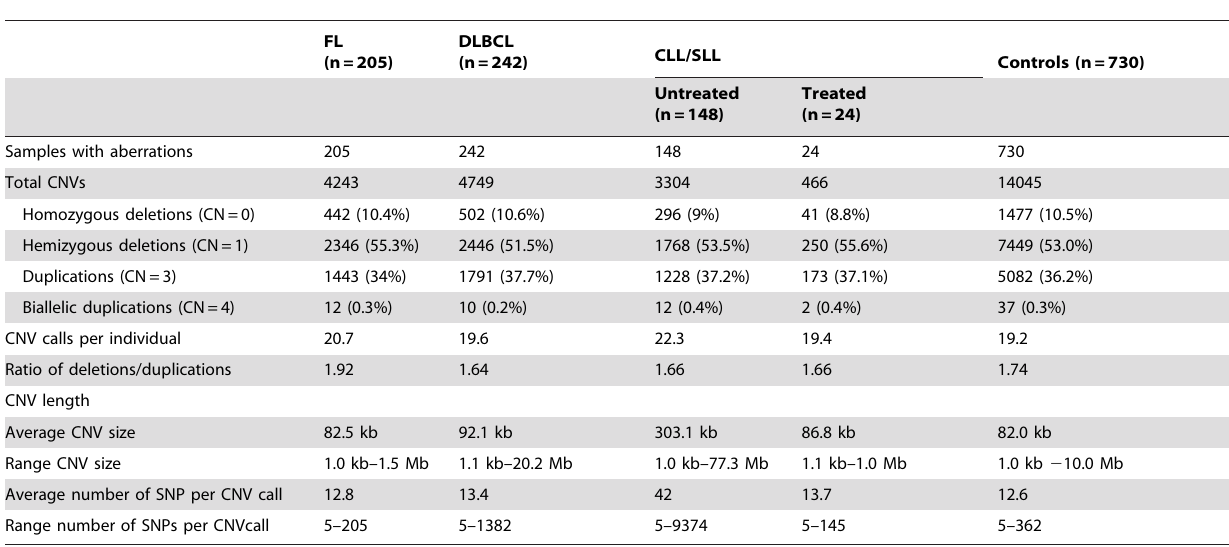
Table 1. Summary of the copy number variation (CNV) analysis by lymphoma